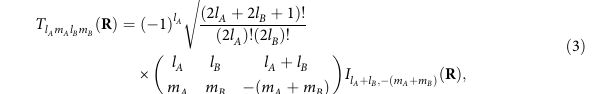
ffiffiffiffiffiffiffiffiffiffiffiffiffiffiffiffiffiffiffiffiffiffiffiffiffiffiffiffiffiffiffi ð 2 l þ 2 l þ 1 Þ ! A B 2